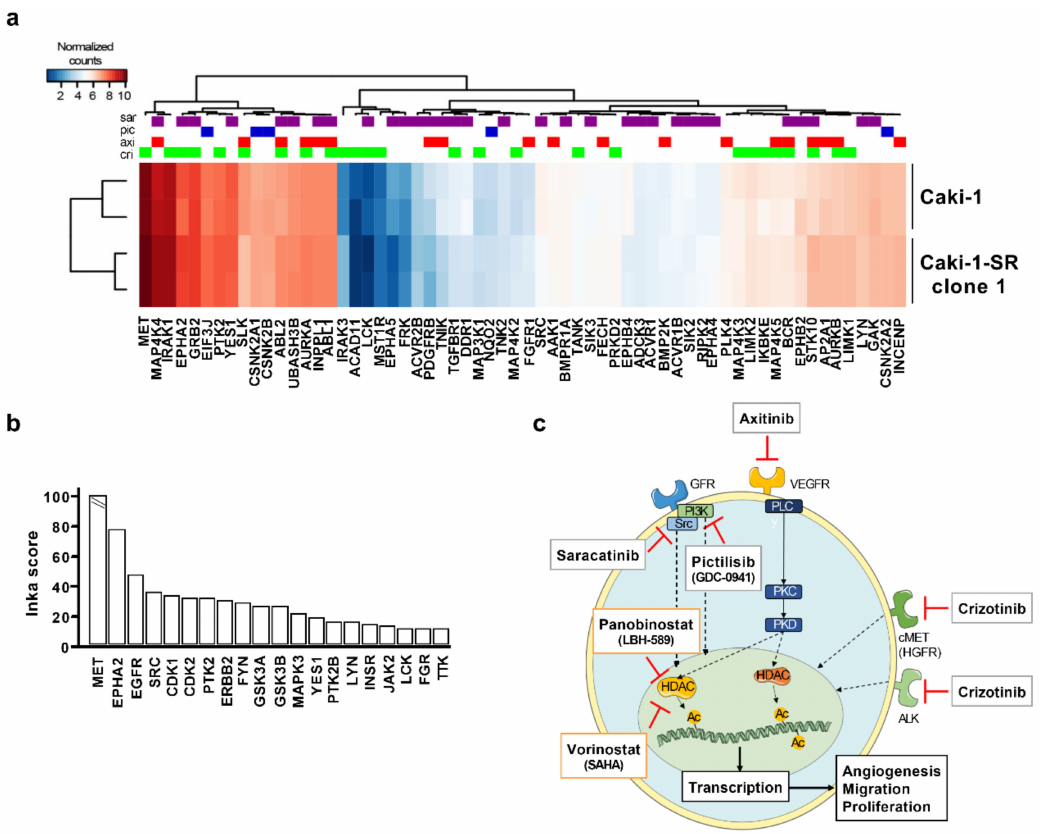
Figure 4. Importance of MET, MAPK, and Src signaling to enhance the cytotoxic activity of the multidrug combination and its translation. ( a ) Heat map of RNA expression in Caki-1 and sunitinib-resistant Caki-1 cells for the tyrosine kinase inhibitor targets as specified by ProteomicsDB. Drugs are color-coded as indicated. ( b ) Phosphoproteomic analysis of Caki-1 cells to determine potential drug targets. The INKA score on the Y -axis represents a measure of phosphotyrosine kinase activity. ( c ) Schematic drawing of the mechanism of action of the multidrug combination and MAPK-inhibiting agents selected through the RNA sequencing and phosphoproteomic analysis. Abbreviations: Ac-Acetyl; cMET–Tyrosine-protein kinase Met or (HGFR) hepatocyte growth factor receptor; HDAC–Histone deacetylase; PI3K–Phosphatidylinositol-3-kinase; PLC–Phospholipase C γ ; PKC–Phosphokinase C; PKD–Phosphokinase D; (VE)GFR–(Vascular endothelial) growth factor receptor; Src–Proto-oncogene tyrosine-protein